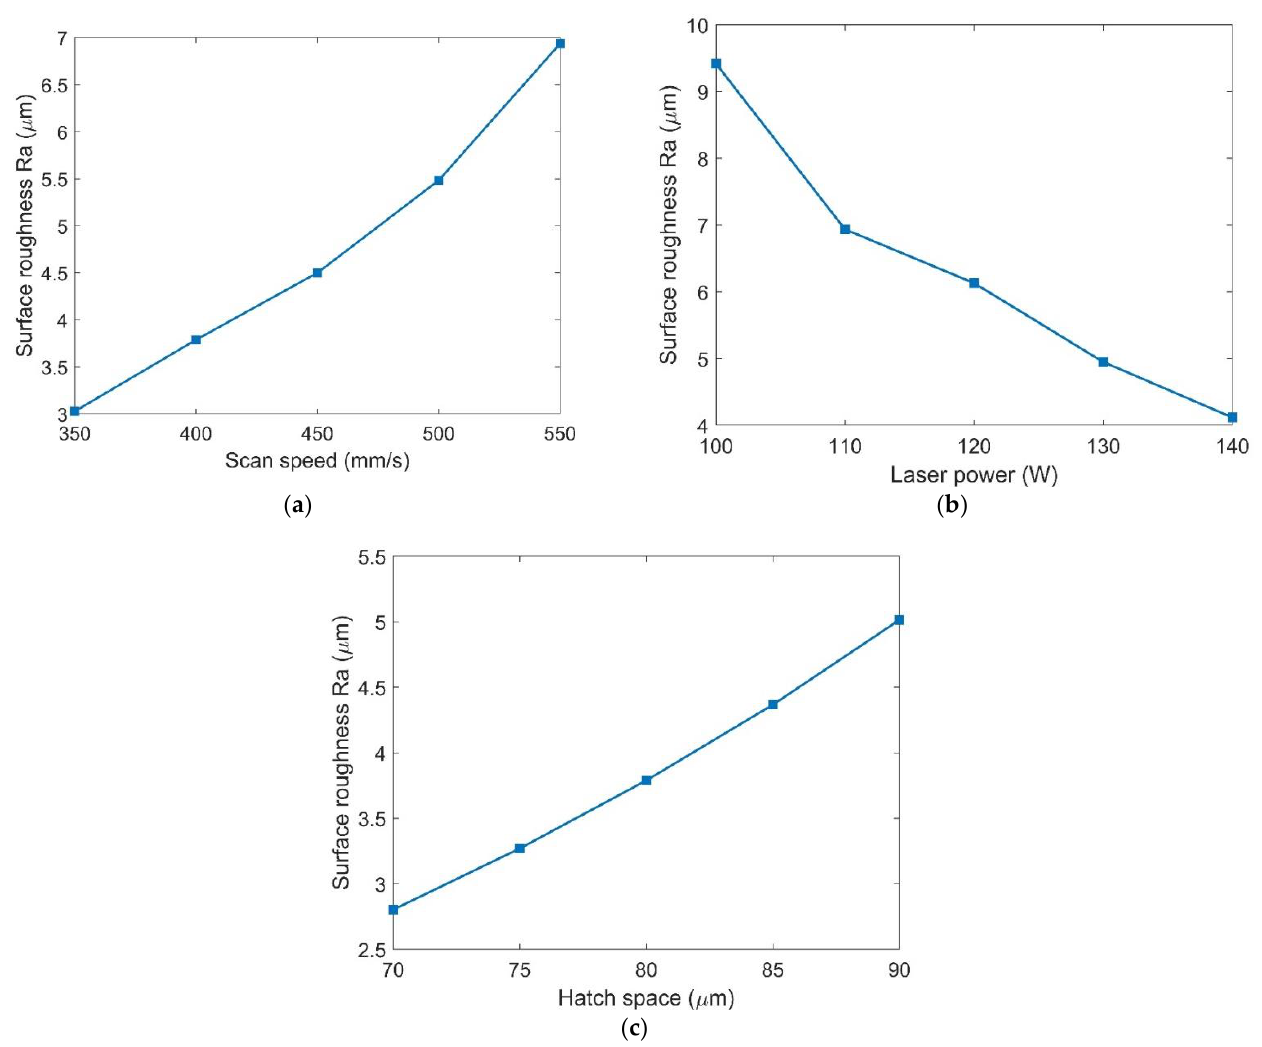
Figure 4. Comparison between predicted and measured surface roughness Ra.